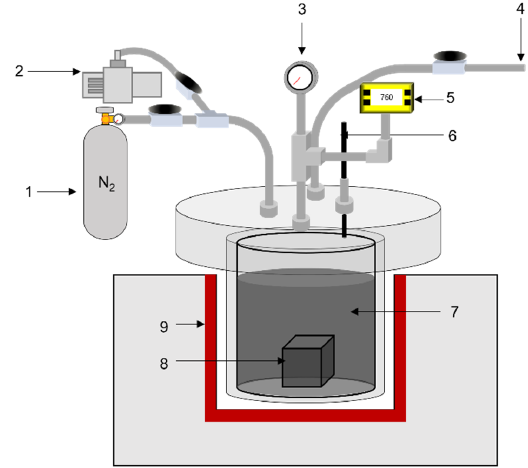
Figure 1. Schematic of impregnation apparatus. (1) N 2 gas, (2) vacuum motor, (3) pressure gauge, (4) gas outlet, (5) vacuum gauge, (6) thermocouple, (7) pitch, (8) graphite block, (9) heating element. 2.4. Density, Porosity, and Impregnation Rate Measurements